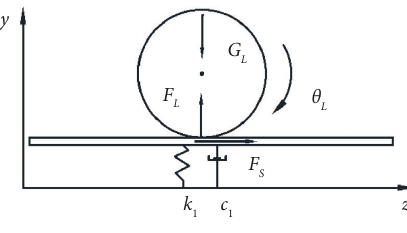
Figure 5: Wheel-rail contact model.